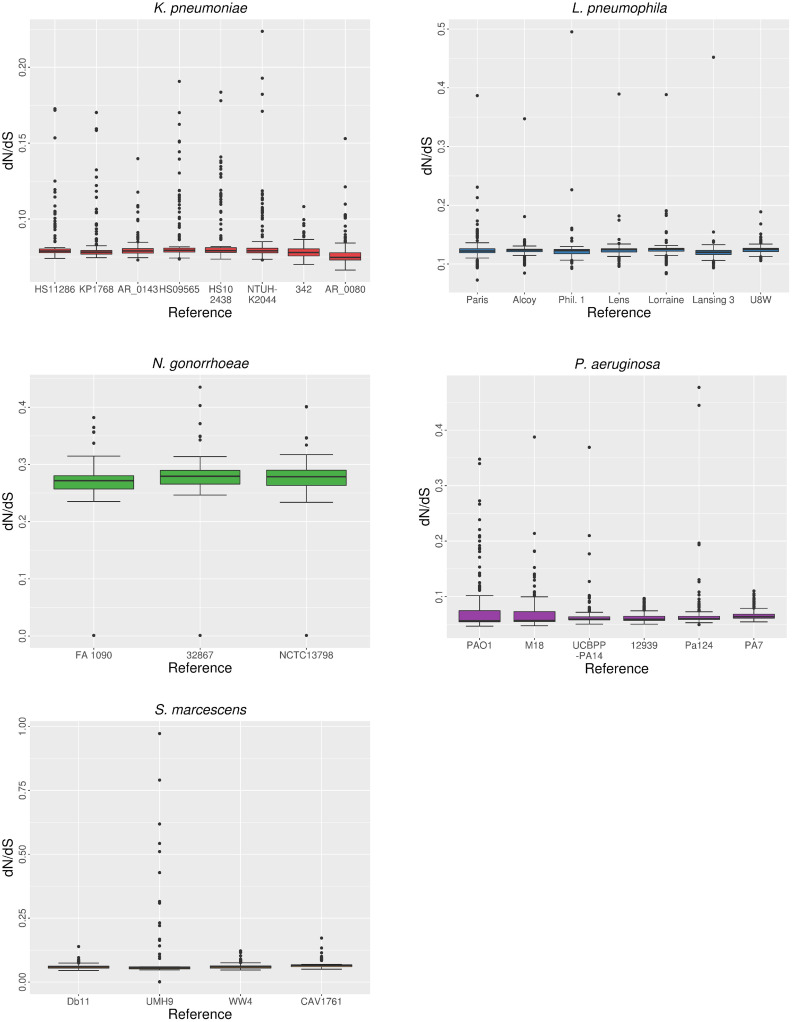
Distribution of dN/dS depending on reference choice.